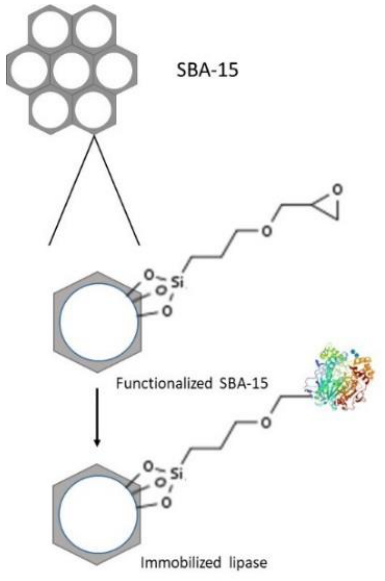
Figure 10. Lipase immobilization on epoxy-functionalized SBA-15.